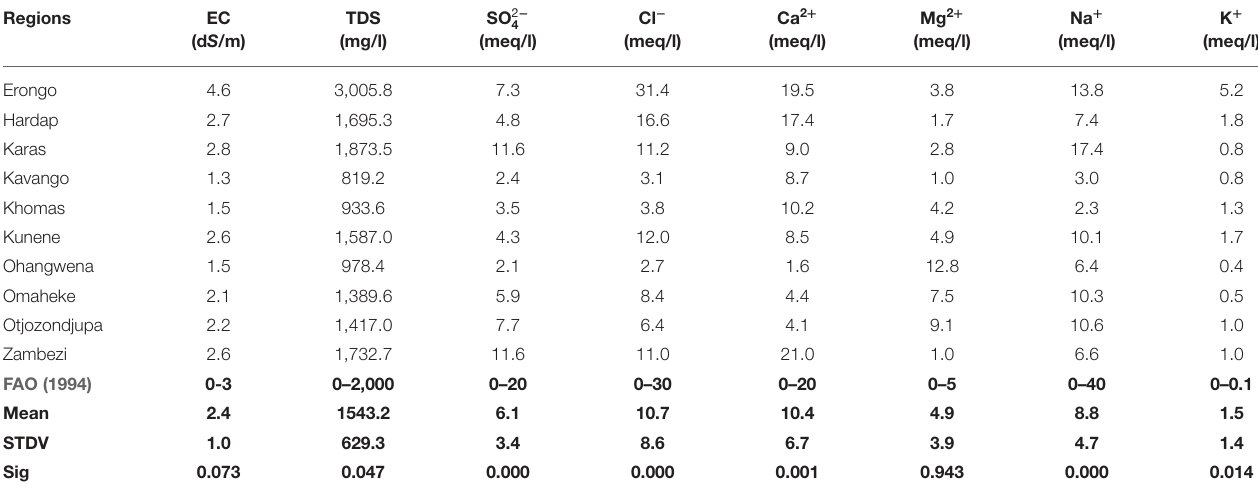
TABLE 8 | Average groundwater parameters. Regions